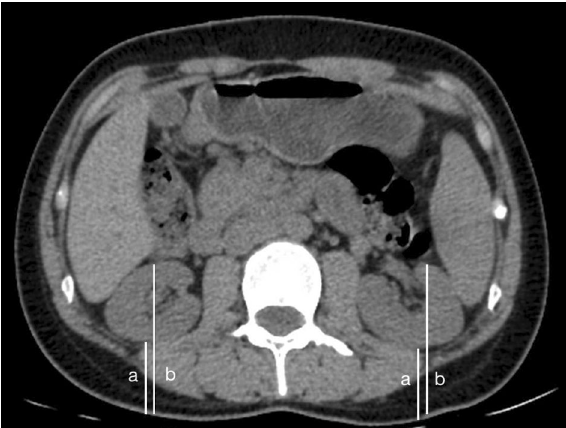
Fig. 2 A CT image was taken to measure the renal depth. For posterior renal depth, renal depth (cm) (a = +